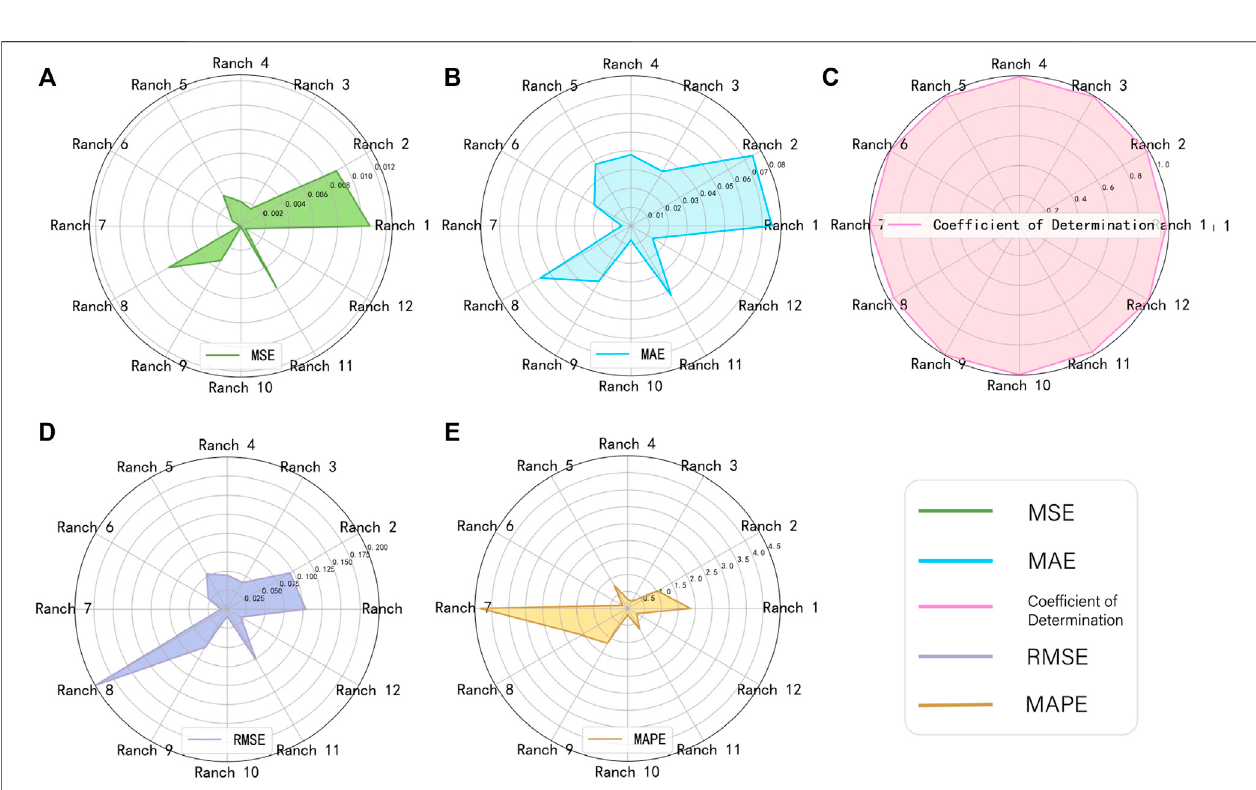
FIGURE11| Radardiagramsofthepredictionerrorevaluationindexesfor12ranchesbasedonthemodelproposedinthispaper. (A) isthevalueofMSE. (B) isthe value of MAE. (C) is the value of RMSE. (D) is the value of MAPE. (E) is the value of R 2 .